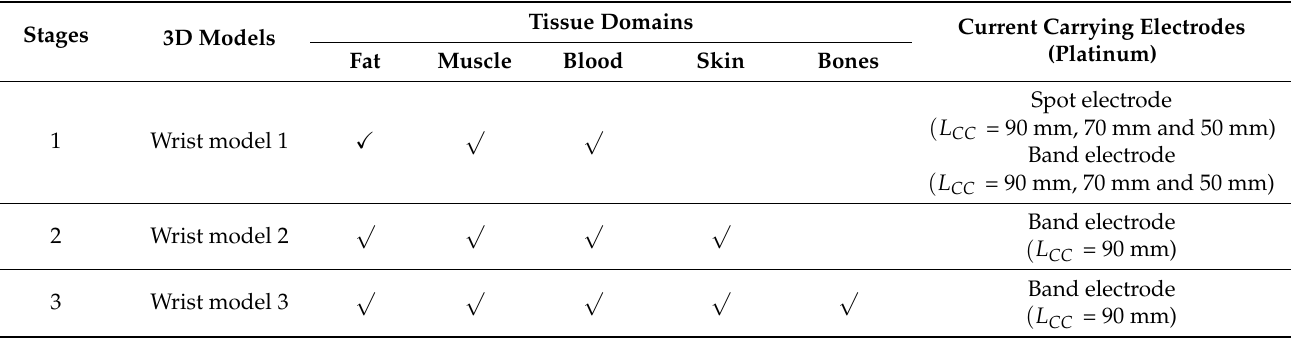
Table 1. Stages for computational